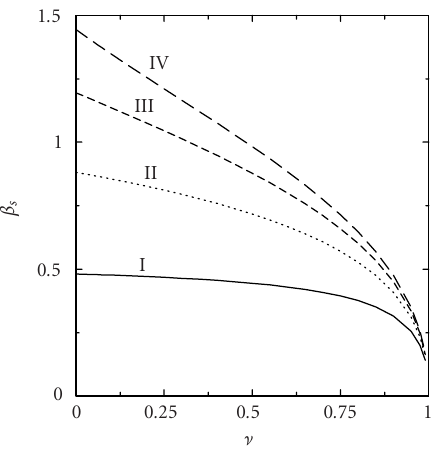
Figure 4.2. The variation of the smaller root β s of (4.3) in the text as a function of the nonintegrability parameter ν for various values of the parameter a . Since λ = − 1, these states are staggered stationary localized states. Curve I: a = 0 . 5, curve II: a = 1 . 0, curve III: a = 1 . 5, and curve IV: a = 2 . 0.